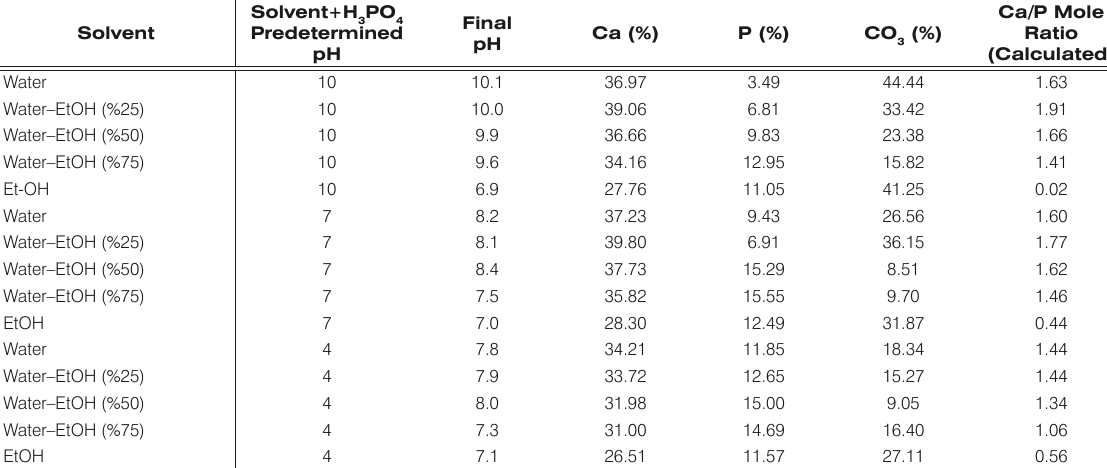
Table 1. Results of the experiments at room temperature.